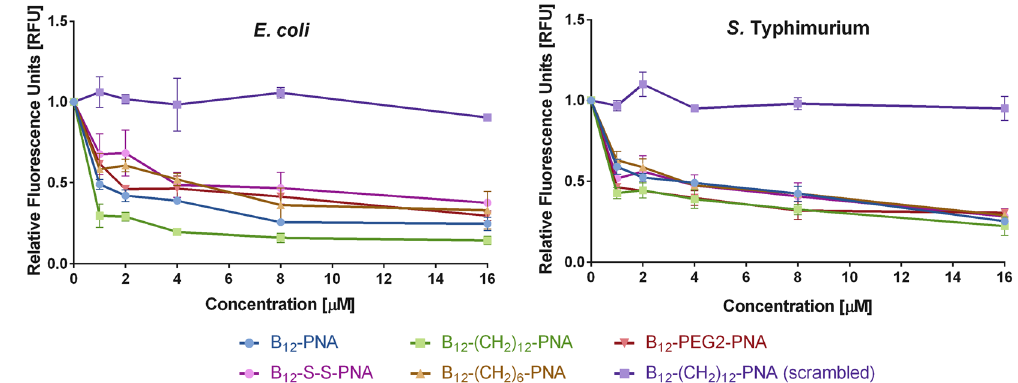
Figure 6. Relative fluorescence measured in cells after treatment with conjugates of vitamin B 12 -PNA targeted at the mRNA encoding RFP. Data for all tested concentrations are shown in Table S2. The differences between RFU of B 12 -(CH 2 ) 12 -PNA(scrambled) and the rest of tested conjugates are highly significant with P ≤ 0.001. In addition, for E. coli : the difference between B 12 -(CH 2 ) 12 -PNA and B 12 -(CH 2 ) 6 -PNA is significant with P ≤ 0.01 and the difference between B 12 -(CH 2 ) 12 -PNA and B 12 -PEG2-PNA is marginally significant (P ≤ 0.05). The differences between other tested conjugates are not significant (P >